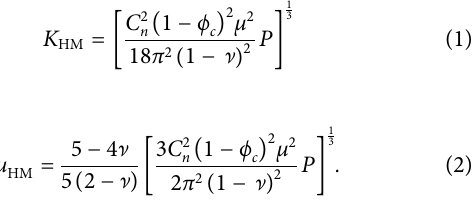
Frontiers in Earth Science |